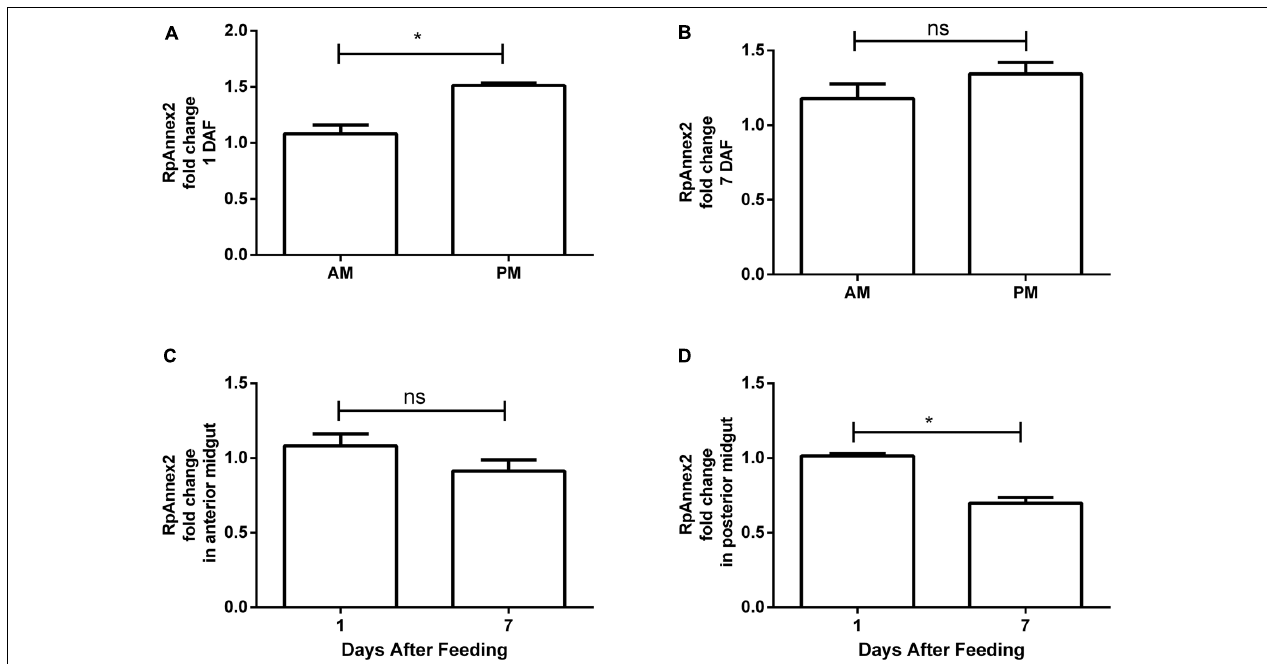
FIGURE 7 | Spatial and temporal relative gene expression of RPRC003519 (RpAnnex2) in fifth instar nymphs of Rhodnius prolixus . Blood-fed insects were dissected, and tissues were separated in anterior midgut (AM) and posterior midgut (PM) at 1 and 7 days after feeding. (A) Expression of RpAnnex2 in AM and PM at 1 day after blood feeding, (B) Expression of RpAnnex2 in AM and PM at 7 day after blood feeding, (C) Expression of RpAnnex2 in AM at 1 and 7 days after blood feeding, (D) Expression of RpAnnex2 in PM at 1 and 7 days after blood feeding. Calibrators genes used in the relative quantification of gene expression were α -tubulin and GAPDH . Bars represent the mean ± the standard error of the mean (SEM) of two independent experiments with three pools of R. prolixus ( n = 3). Means were compared applying Student’s t -test; * p < 0.05, and ns stands for